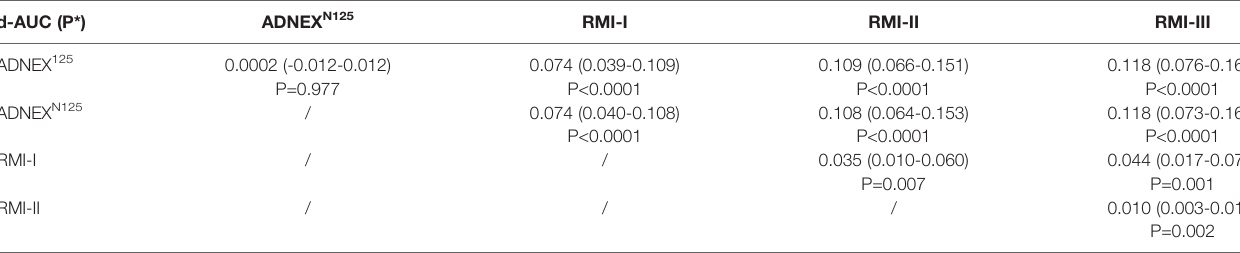
TABLE 4 | Pairwise ROC curve comparisons expressed as differences in AUC and P-values for the study. d-AUC